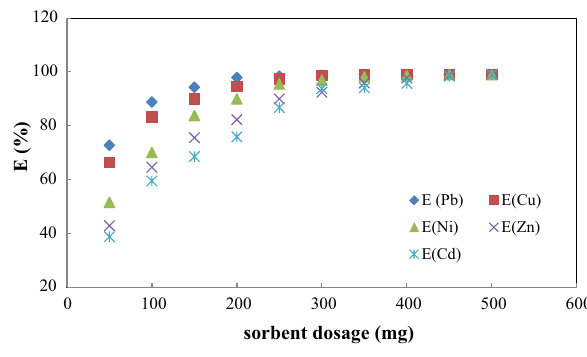
Fig. 4 Effect of the sorbent dose on the % removal of Zn(II), Ni(II), Cu(II), Pb(II) and Cd(II) by Posidonia oceanica